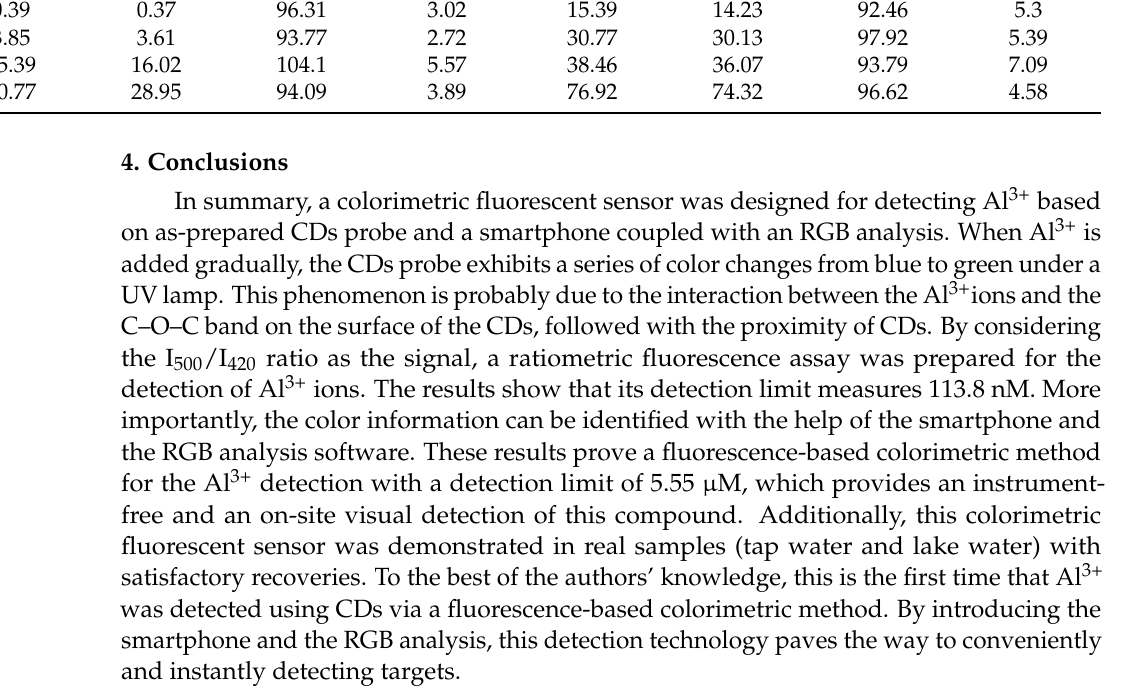
Table S1: Comparison among different methods used in the Al 3+